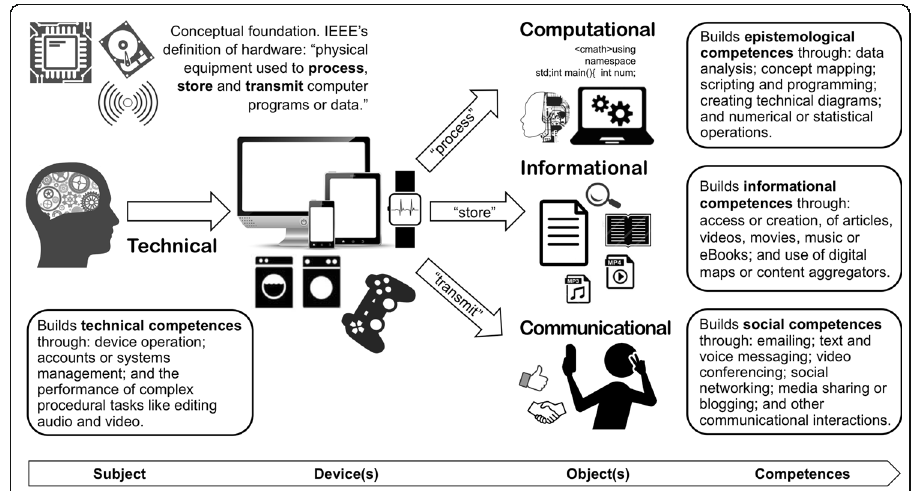
Fig. 1 Conceptual overview of GTCU framework, authored by Desjardins